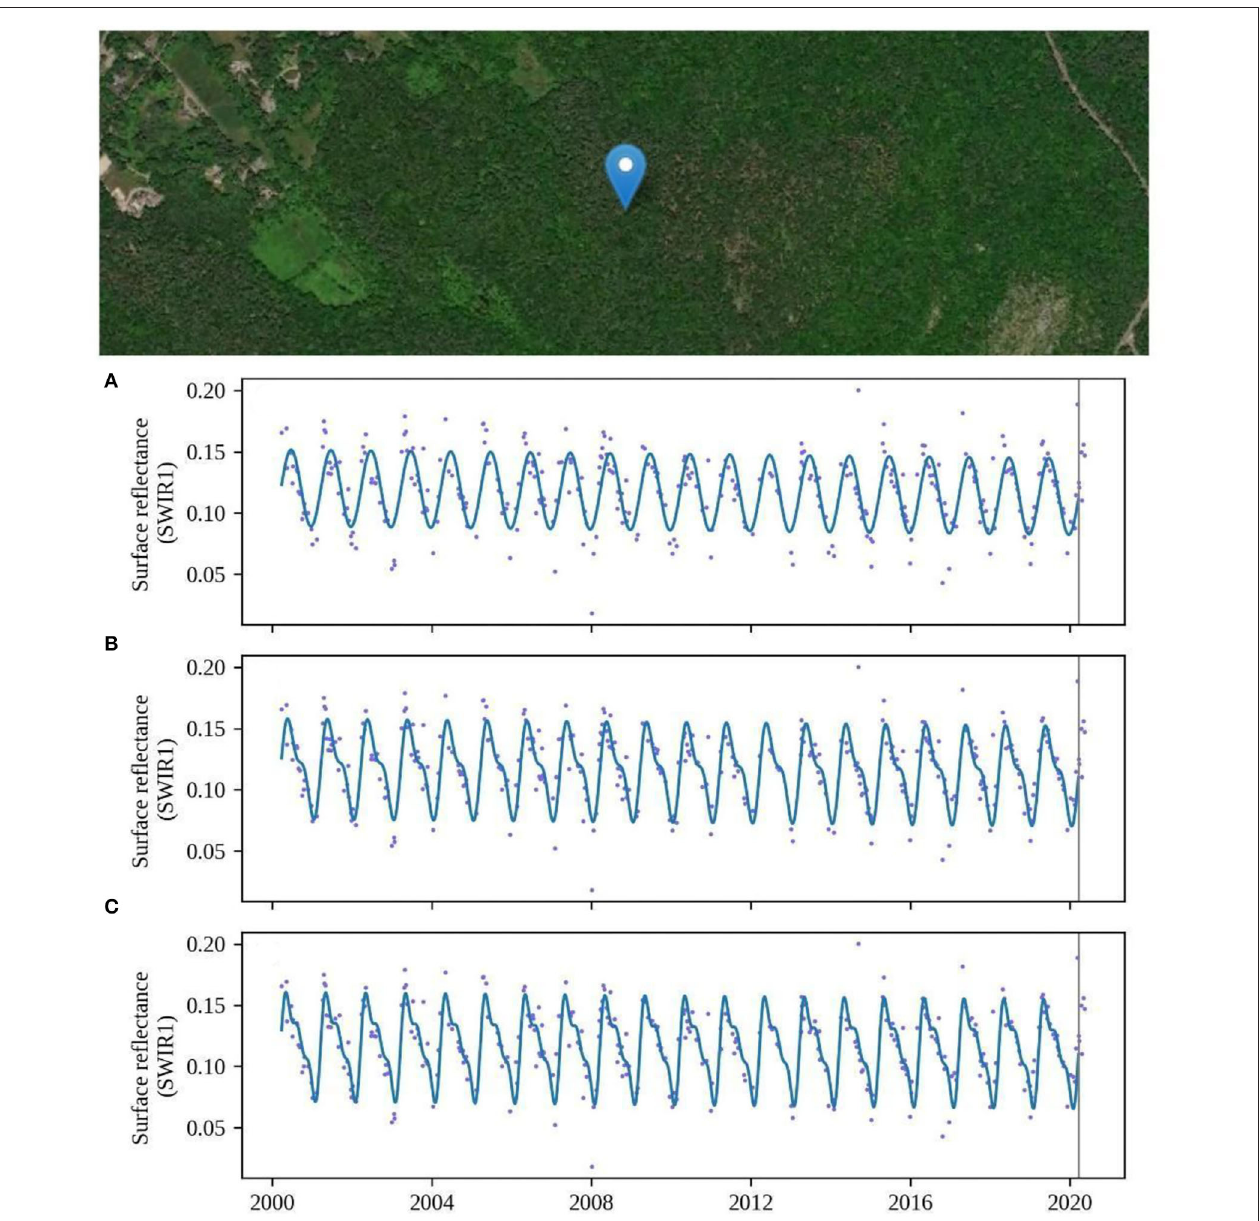
FIGURE 1 | Landsat time series (dots) for the SWIR1 band, and the corresponding time segments detected by the CCDC algorithm, using different numbers of harmonics. (A) Time segment using only one harmonic (annual harmonic), (B) two harmonics (annual and six-month harmonics), and (C) three harmonics (annual, 6-, and 3-months harmonics). The pixel corresponds to a stable forest in the Blue Hills Reservation, in the commonwealth of Massachusetts, USA. Only a single spectral band is shown here, but CCDC fits harmonic models to all bands included in the analysis, which are specified by the